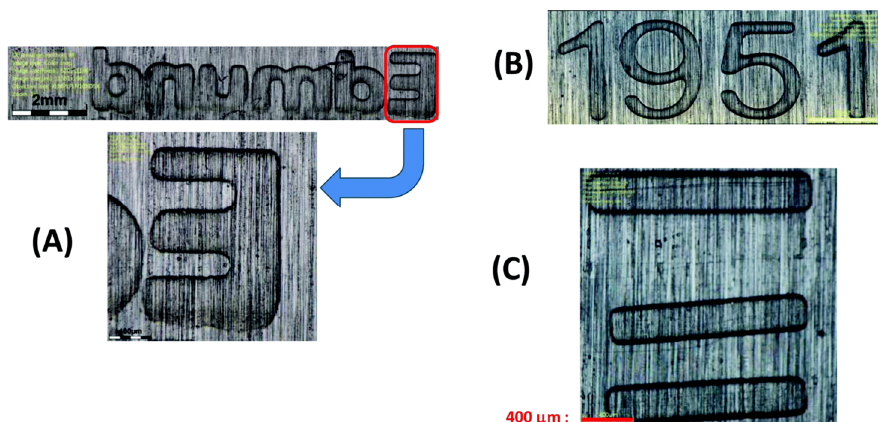
Figure 14. Examples of surface patterning realizing with a LED projector at 405 nm and imaged with a numerical optical microscope using a 1951 USAF resolution test target. ( A ) different letters written ( B ) 1951 ( C ) straight lines. Reproduced with permission from the authors of [82]. Copyright 2017 The Royal Society of Chemistry.